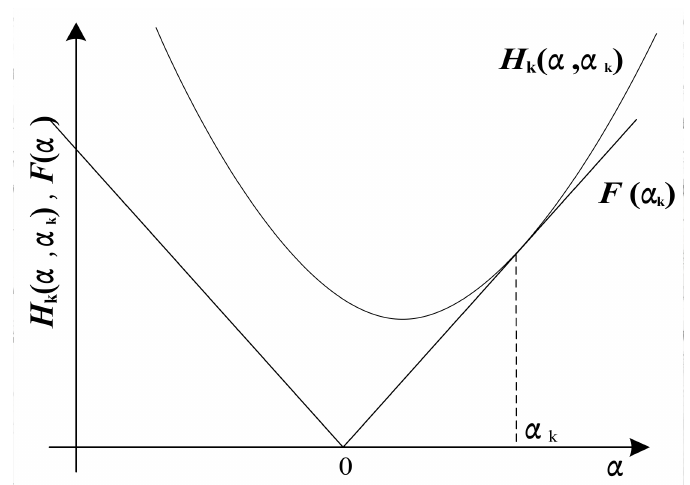
Figure 2. Sparse iterative algorithm based on